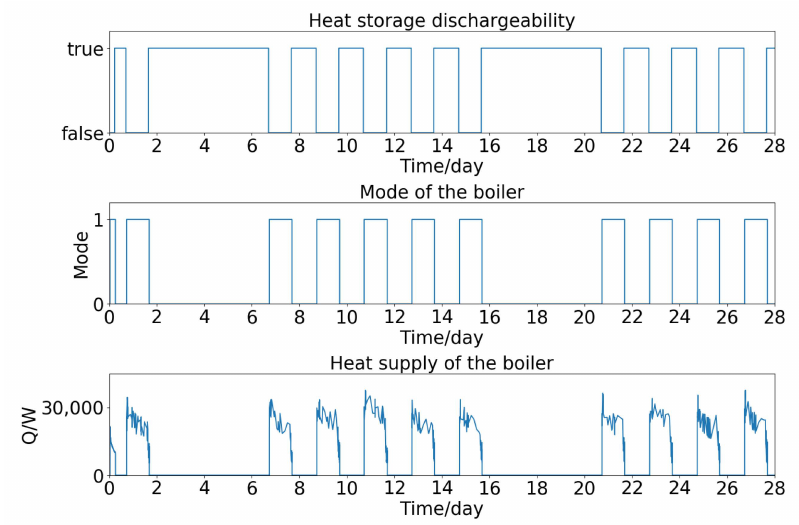
Figure 13. The simulation results of heat supply subsystem 1 containing a heat storage and a boiler as time series in the winter phase.